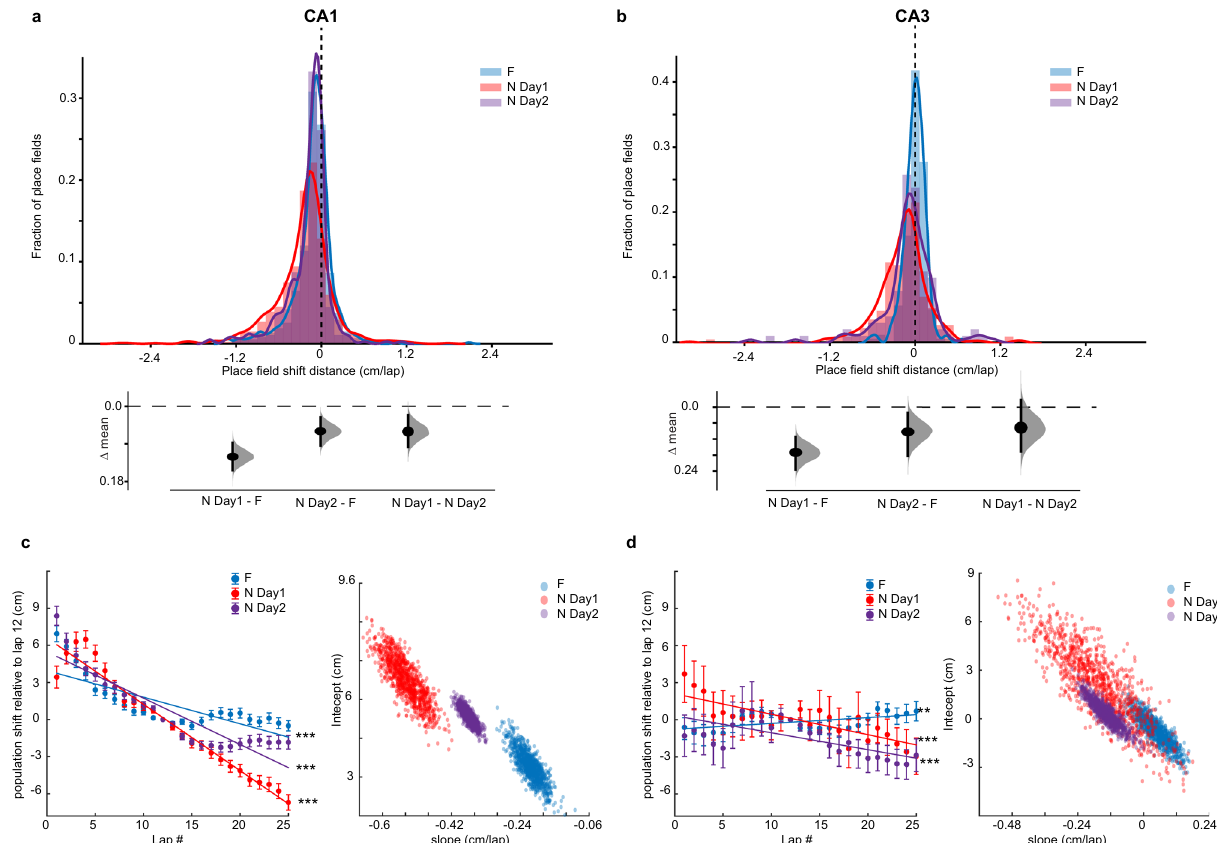
Fig. 6 Population backward shifting slows down with familiarization across days. a Top, histograms of COM last_lap – COM onset_lap (session shift de fi ned as in Fig. 3d) in Familiar (F), N day 1 and N day 2, for CA1. Bottom, bootstrapped mean differences ( Δ ) between the three conditions. b Same as a for CA3. c Population shift of PF COM. Left, mean ±SEM, over all PFs, of fi ve-lap sliding average COM difference relative to lap 12 (see Methods), comparing CA1 population shifts in F (blue), N day 1 (red), and N day 2 (purple). Linear regression, F test, *** P < 0.001, F, P = 3.1 × 10 − 86 , N Day 1, P < 1 × 10 − 100 , N Day 2, P < 1 × 10 − 100 . The resampling analysis uses a number of PFs equal to 80% of the number of PFs in the condition with the lowest number of PFs (1000 resamples). The lack of distribution overlap between conditions indicates dynamics are signi fi cantly different. d Same as c for CA3. Overlap in the slope distributions suggests that population dynamics are similarly fl at (slopes close to 0) although CA3 PFs shifting become more homogeneous (smaller variance) with familiarization. Linear regression, F test, *** P < 0.001, F, P = 0.005, N Day 1, P = 1.3 × 10 − 4 , N Day 2, P = 1.1 × 10 − 4